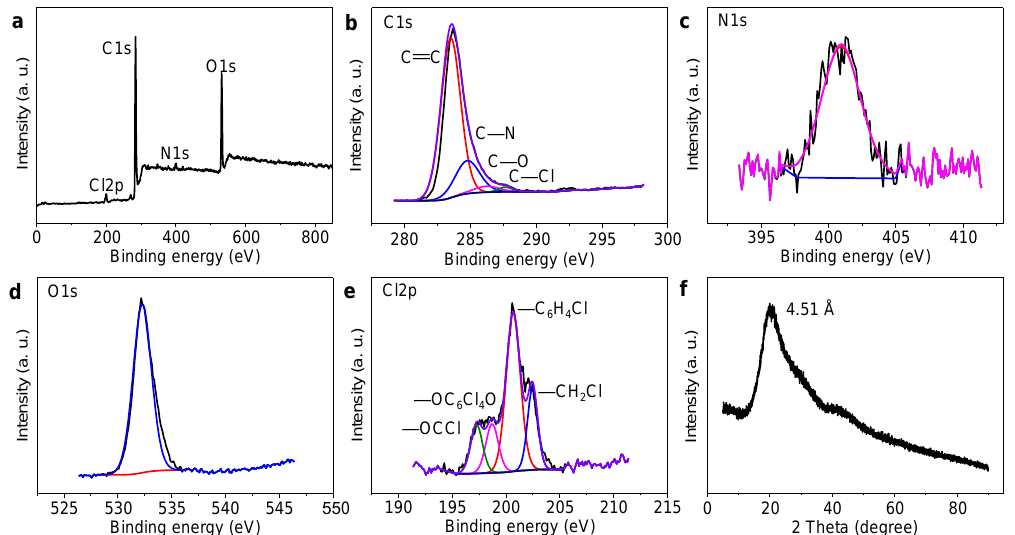
Figure 2. Structure characterization of Cl-GQDs: ( a ) XPS survey spectrum, ( b ) C1s, ( c ) N1s, ( d ) O1s, ( e ) Cl2p, ( f ) XRD patterns of Cl-GQDs.